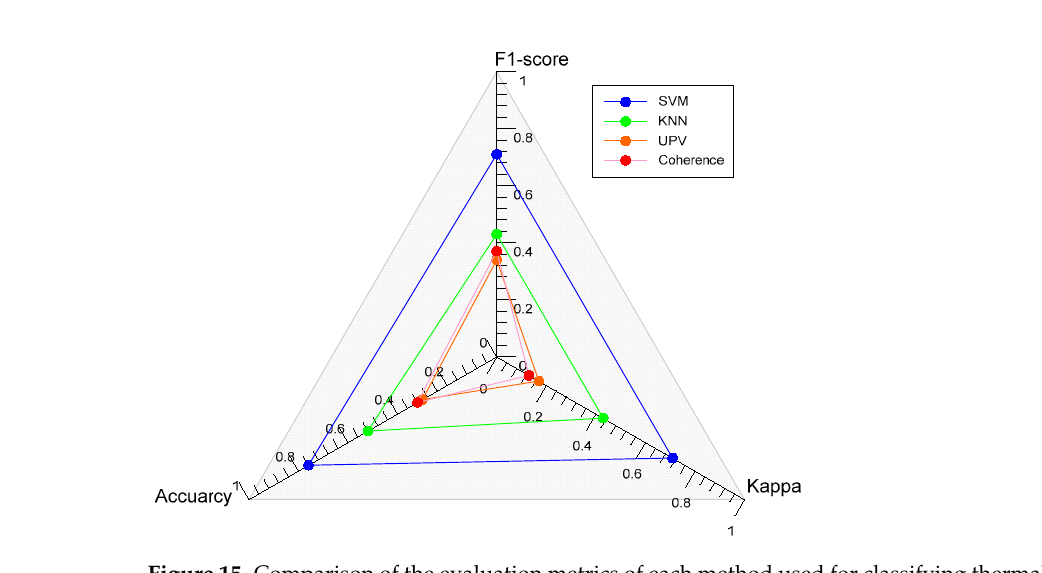
Figure 15. Comparison of the evaluation metrics of each method used for classifying thermal damage of concrete.